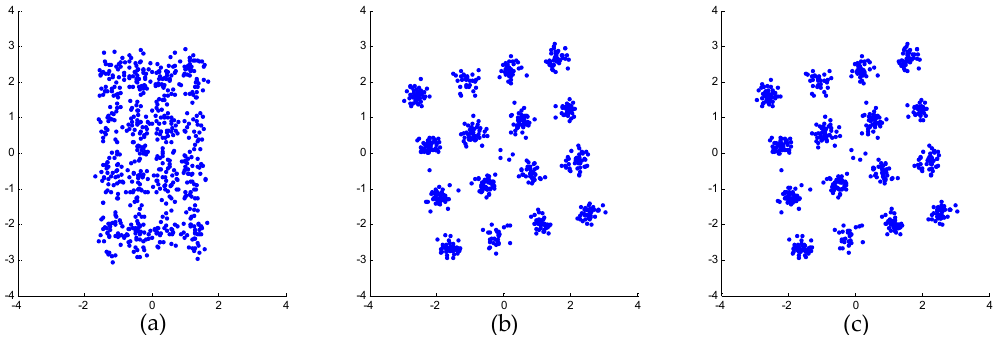
Figure 8. Demodulated constellations of the 16-QAM (quadrature amplitude modulation) signals in the polluted regions: ( a ) unmitigated signal; ( b ) output of AIC; ( c ) output of the proposed algorithm.